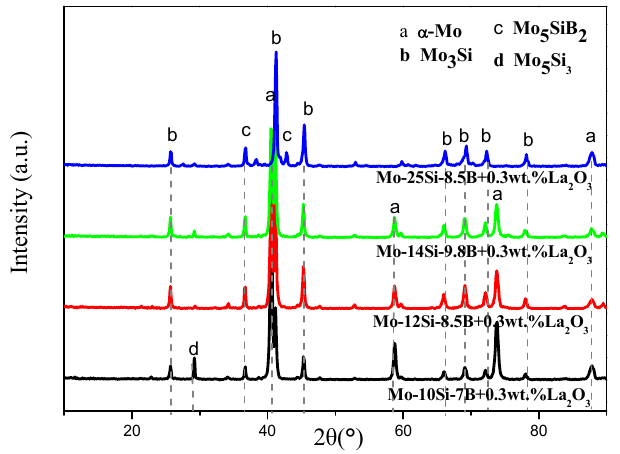
Figure 1. XRD patterns of di ff erent Mo-Si-B alloys.